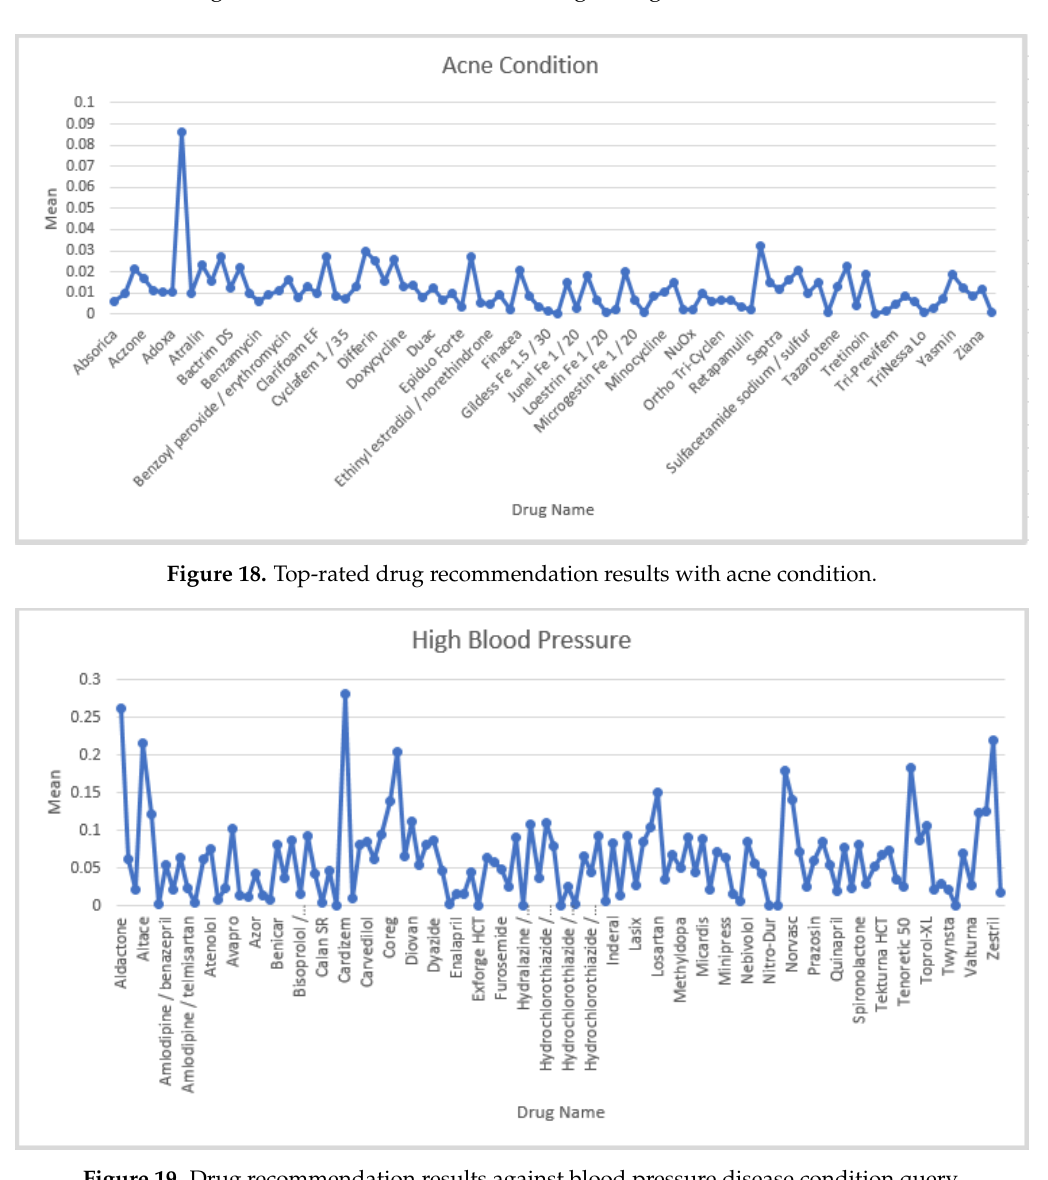
Figure 19. Drug recommendation results against blood pressure disease condition